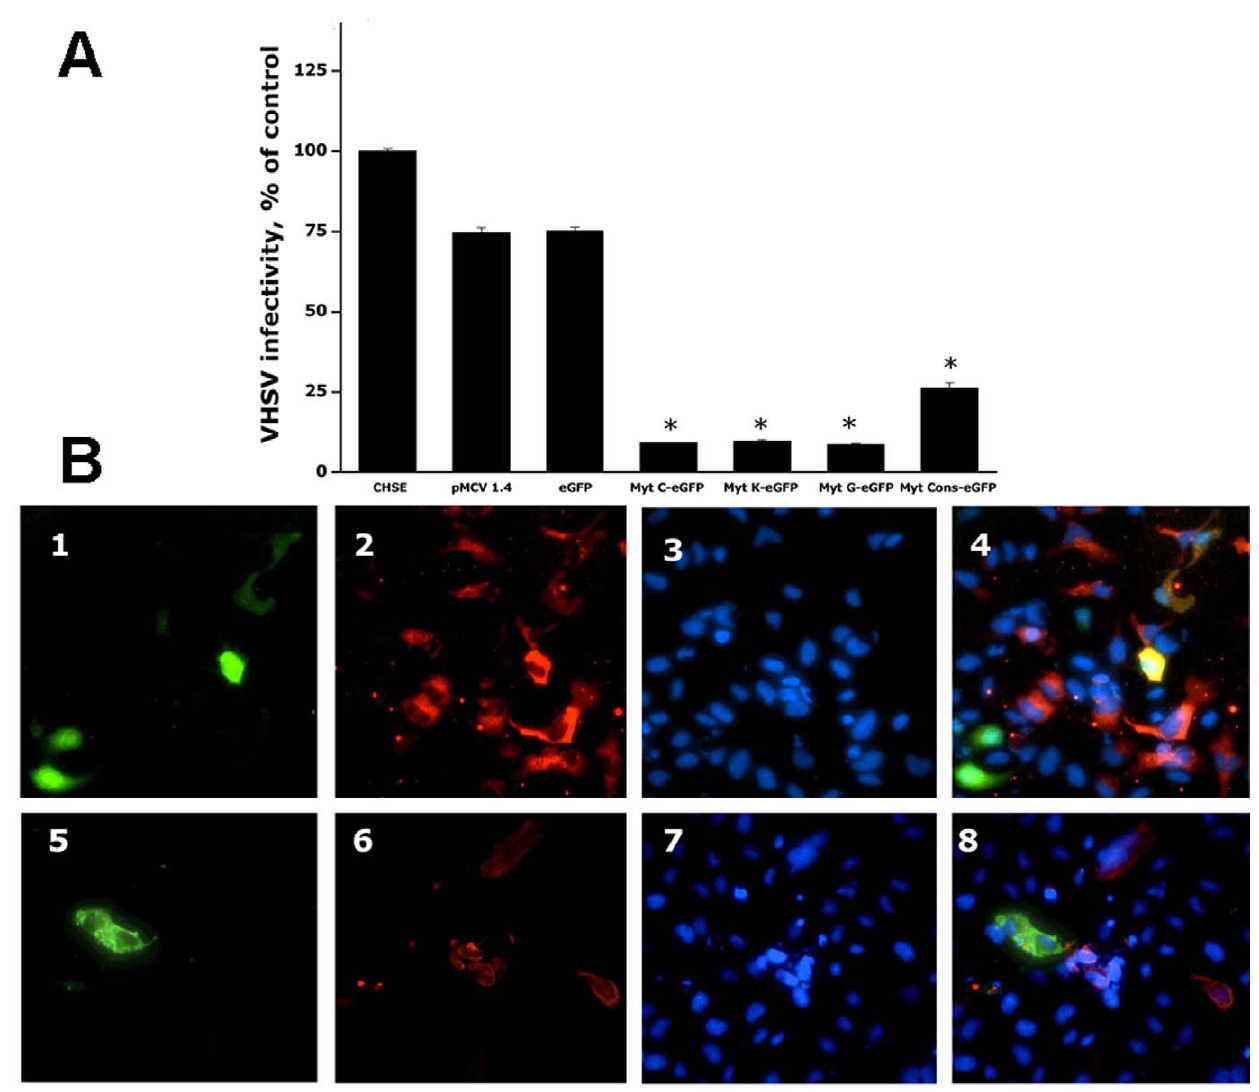
Figure 4. Resistance of CHSE cells expressing the Myt C variants to VHSV infection. CHSE cells were non-transfected or transfected with pMCV1.4, pMCV1.4-eGFP or with each of the pMCV1.4-Myt C-eGFP plasmids for 24 h, washed and then infected with VHSV for 2 h at 14 u C. After washing unbound virus, the infected cell monolayers were incubated for 24 h at 14 u C, and viral infectivity was estimated by RT-qPCR. A, expression levels of VHSV-pN in infected CHSE cells. The data are presented as the mean 6 S.D. from two independent experiments, each performed in triplicate. Asterisks indicate significant differences (p , 0.01) in viral infectivity relative to control cells (infected but non-transfected CHSE cells). B, VHSV replication in CHSE-Myt C expressing cells. CHSE cells were transfected with pMCV1.4-eGFP (upper panel) or pMCV1.4-Myt Cc-eGFP (lower panel) plasmids and infected with VHSV as above. Cell monolayers were then fixed and stained. 1 and 5 GFP fluorescence (green fluorescence); 2 and 6, stained with the MAb I10 anti-G protein of VHSV and anti IgG-TRITC (red fluorescence); 3 and 7, stained with the Hoechst DNA stain (blue fluorescence); 4 and 8, merged images.